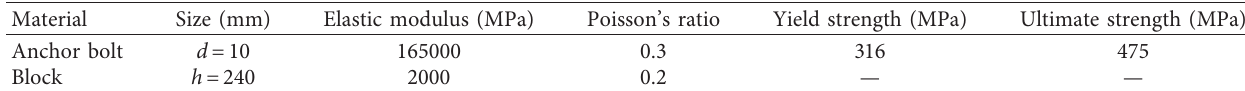
Table 4: Material properties.